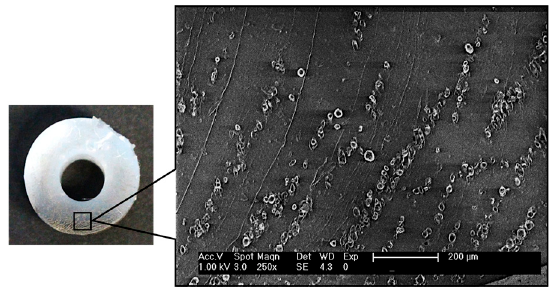
Figure 3. Cross-section of bilayer composite with 2.5 wt % nickel particles and SEM image of a particle-rich area showing aligned particle distribution.